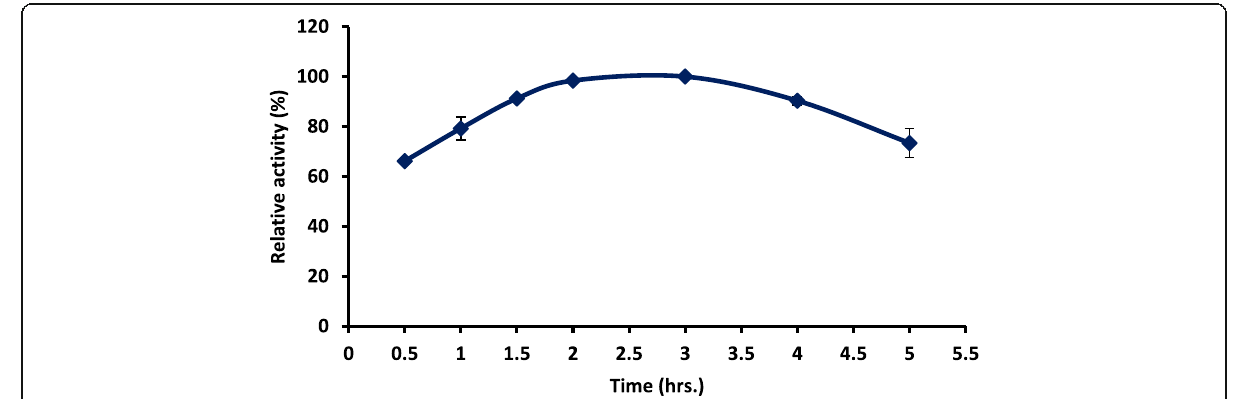
Fig. 6 Effect of variation of GA reaction time on the catalytic activity of immobilized enzyme